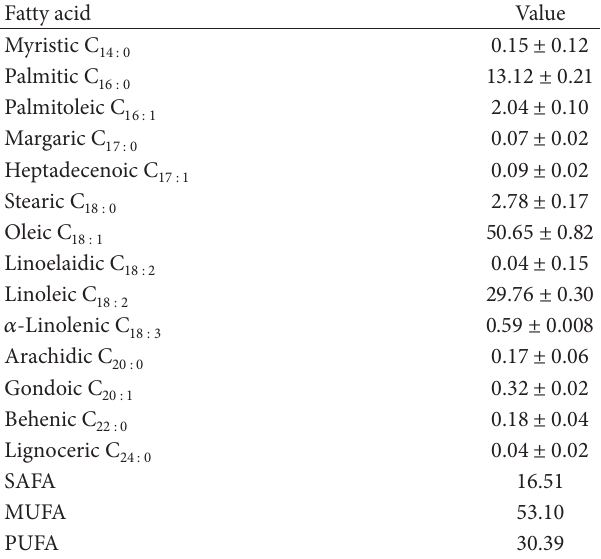
T 1: Fatty acid composition of Pistacia atlantica seed oil (